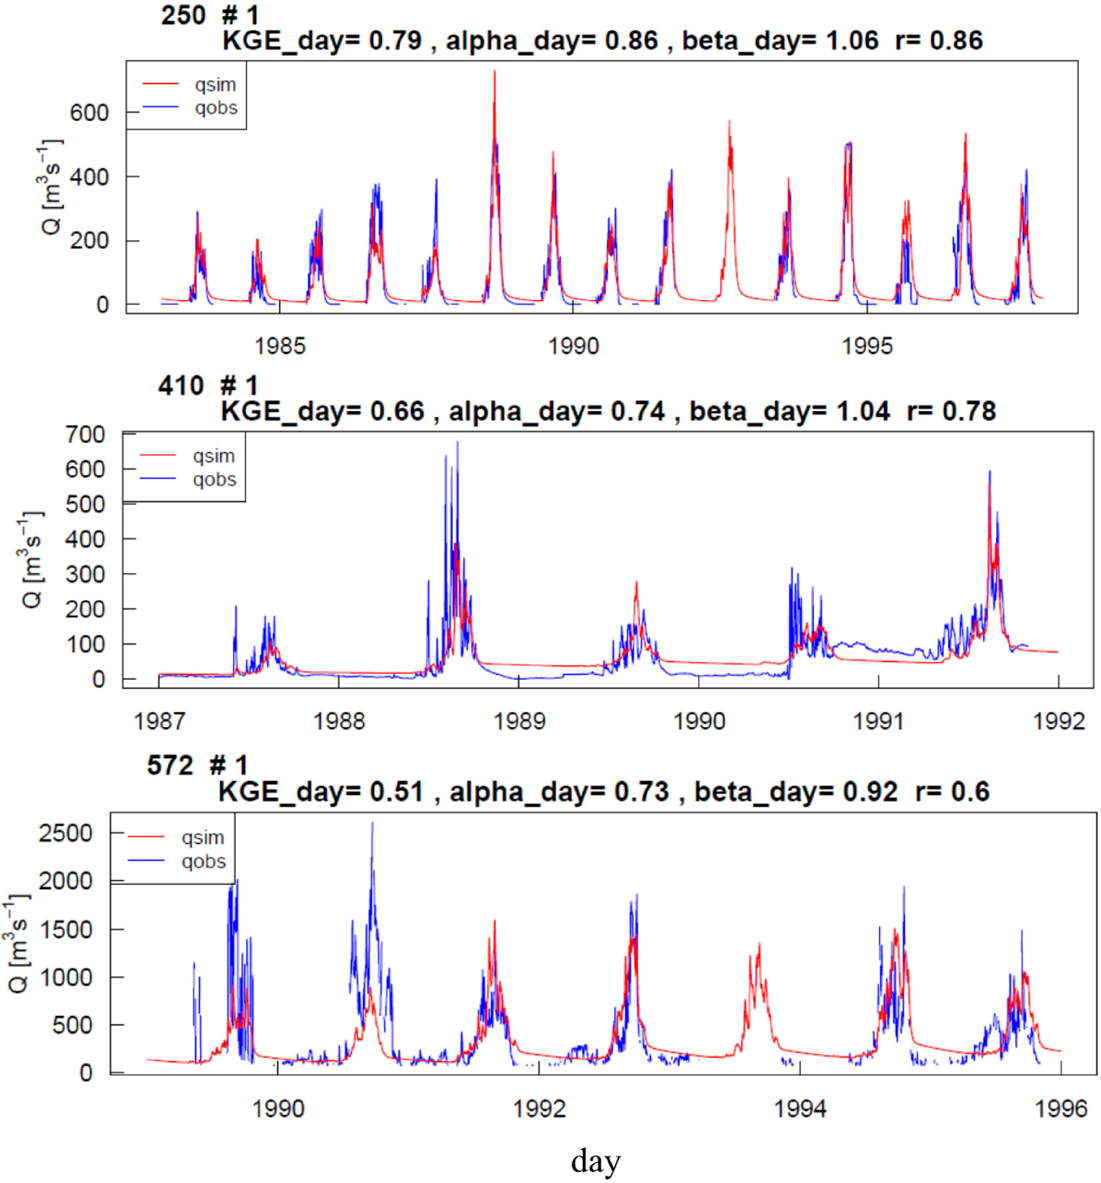
Figure 8. Hydrographs for Jamaare, Hadejia, and Kaduna basins forced with CHIRPS dataset. Generally, daily hydrographs obtained using optimized parameters forced with the CHIRPS dataset for Jamaare (Basin 250), Hadejia (Basin 410), and Kaduna (Basin 572) show acceptable fits between observed and simulated discharge. High correlation values